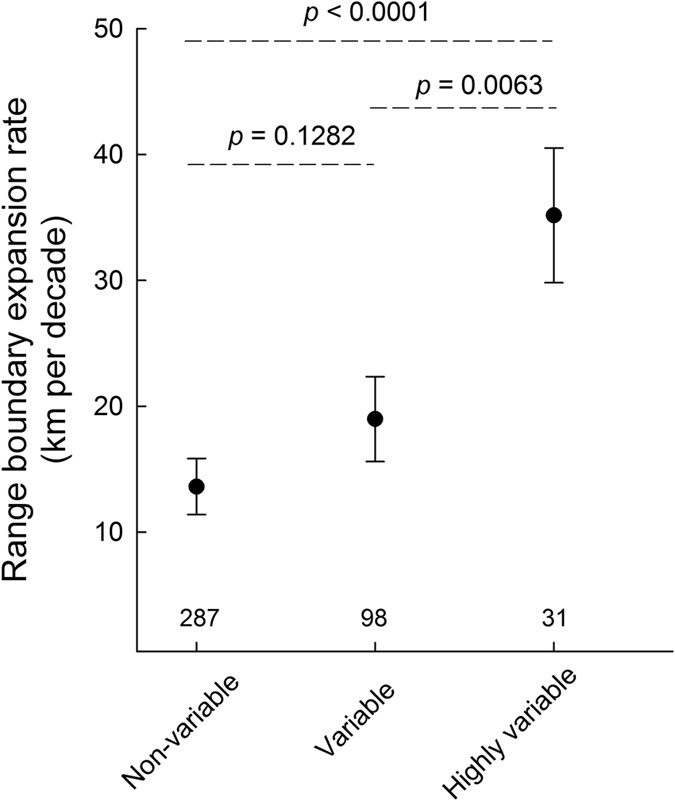
Rates of northward range boundary shifts during the period 1973 to 2014 for species of moths with non-variable, variable, or highly variable colour patterns.Least-squares means ± SE (as obtained from a MIXED model ANOVA). Results, effect of colour pattern: F2,401 = 8.16, P = 0.0003; effect of family: F1,205 = 2.44, P = 0.12, fixed effect of northern boundary in 1973: F1,406 = 103.61, P < 0.0001. The association of faster expansion rates with increasing colour pattern variation did not differ between family Erebidae and Noctuidae (effect of interaction: F2,397 = 0.67, P = 0.51). P-values above dashed lines represent statistical significance of differences of least-squares means. Local and overall effect sizes3940 (Cohen’s f2 = 0.027, Cohen’s d = 0.33) indicated that the magnitude of the effect of colour pattern variation was small to medium. Values above horizontal axis denote number of species.